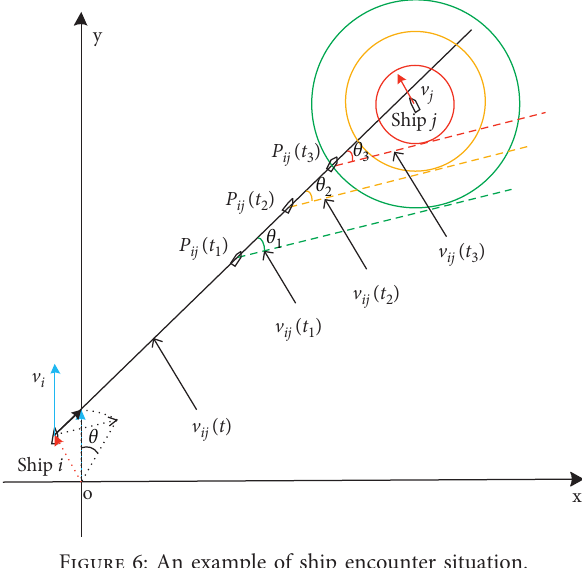
Figure 6: An example of ship encounter